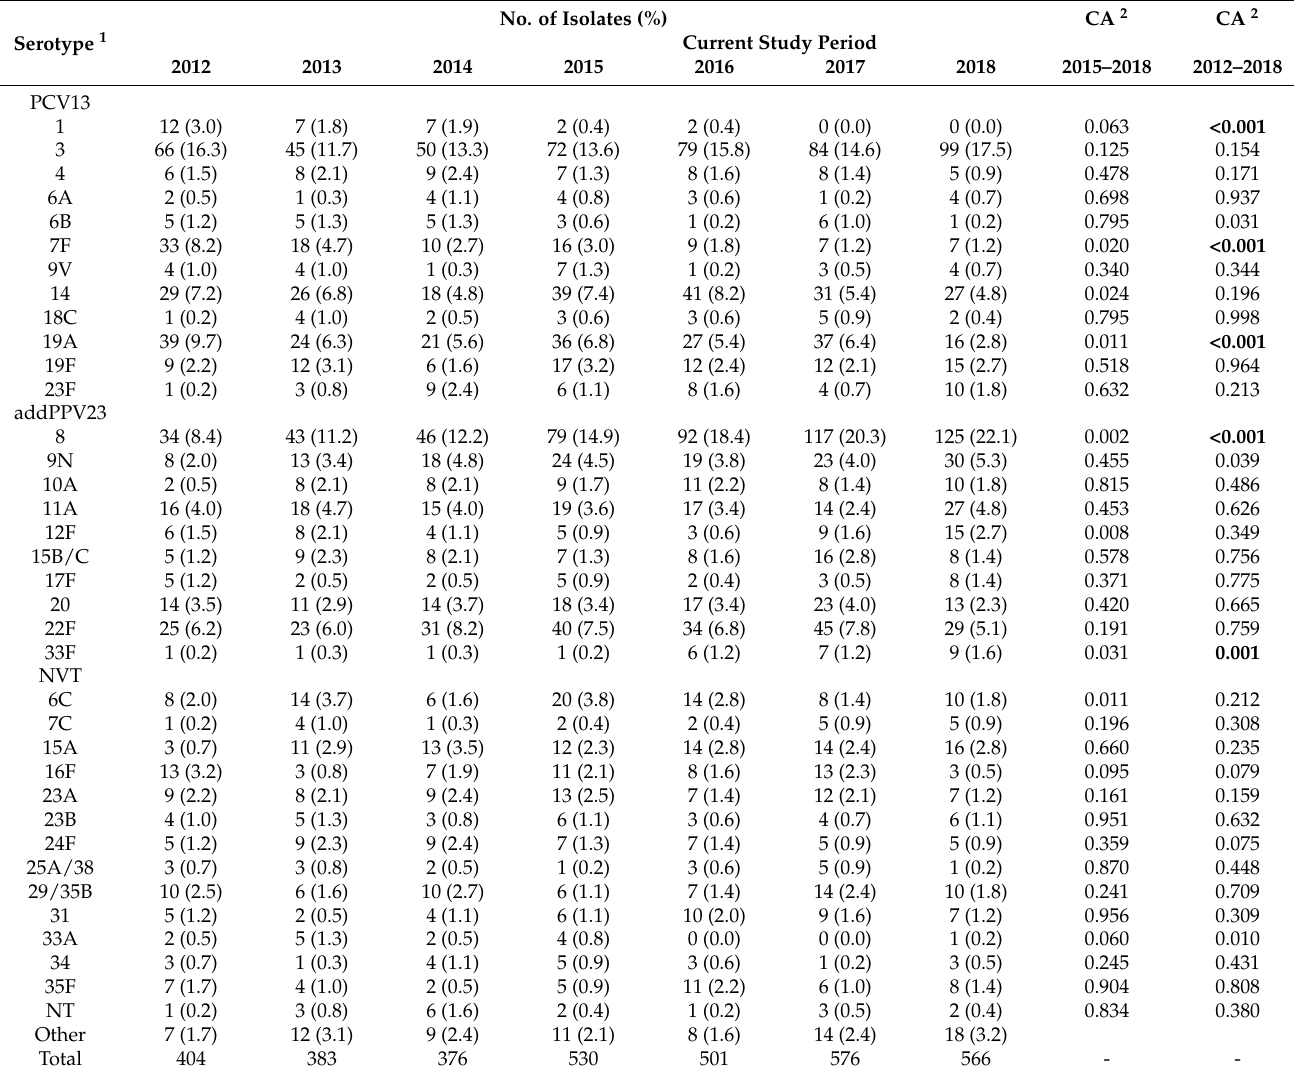
Table 2. Serotypes of the isolates responsible for invasive pneumococcal disease in adult patients ( ≥ 18 years) from 2012 to